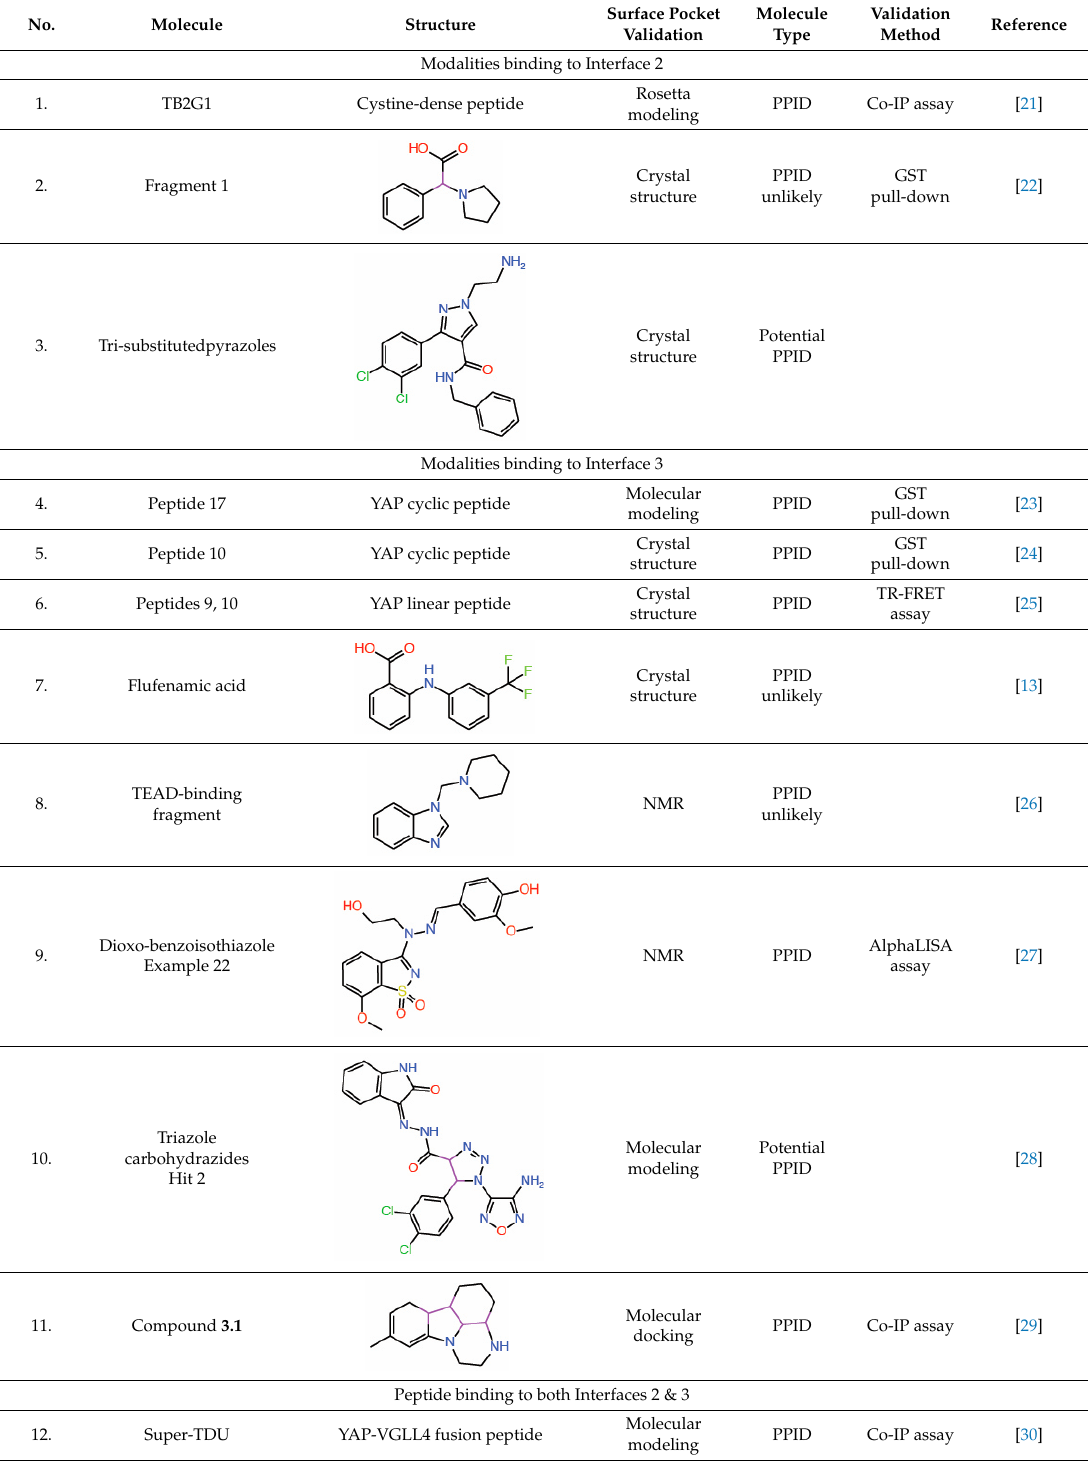
Table 1. Compounds that target TEAD surface pocket interfaces 2 and 3.